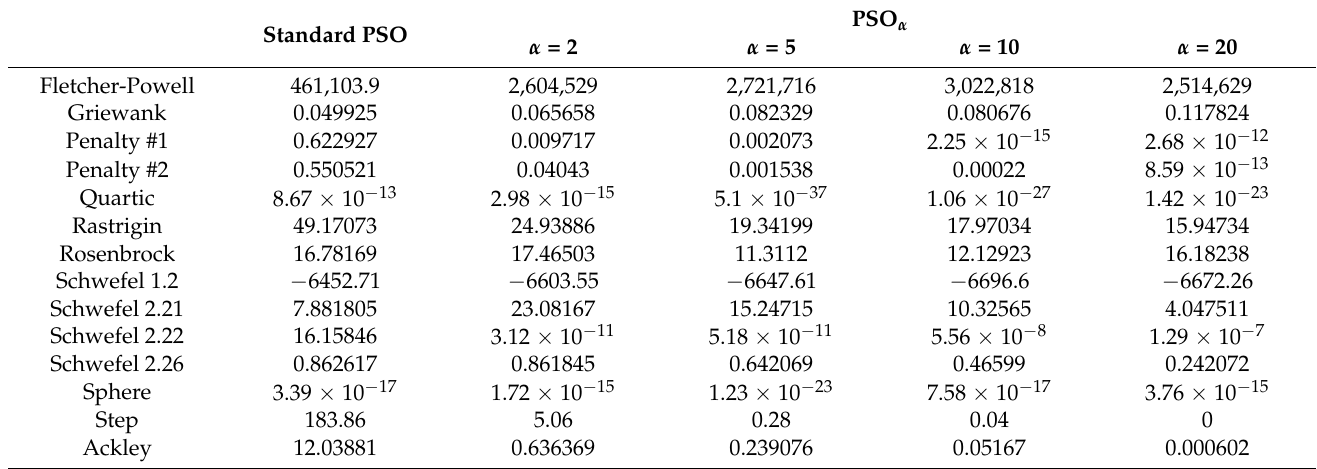
Table 1. Average fitness values of the cost functions for 50 simulations.